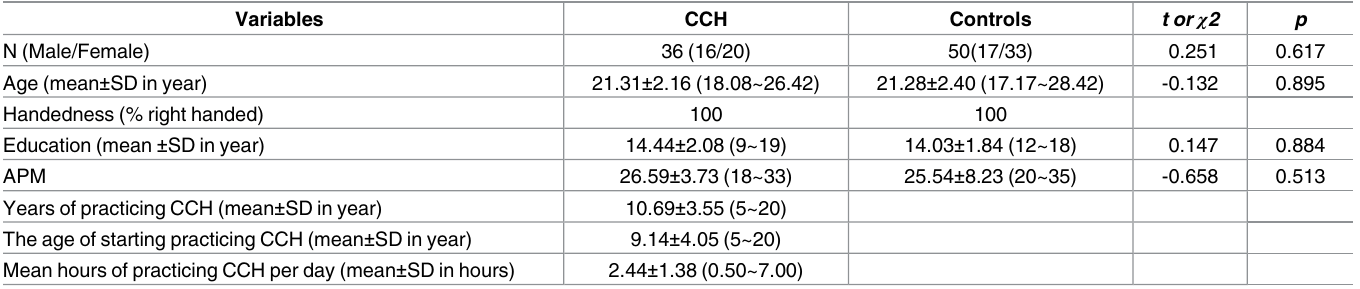
Table 2. Demographic and other information about the CCH group and control